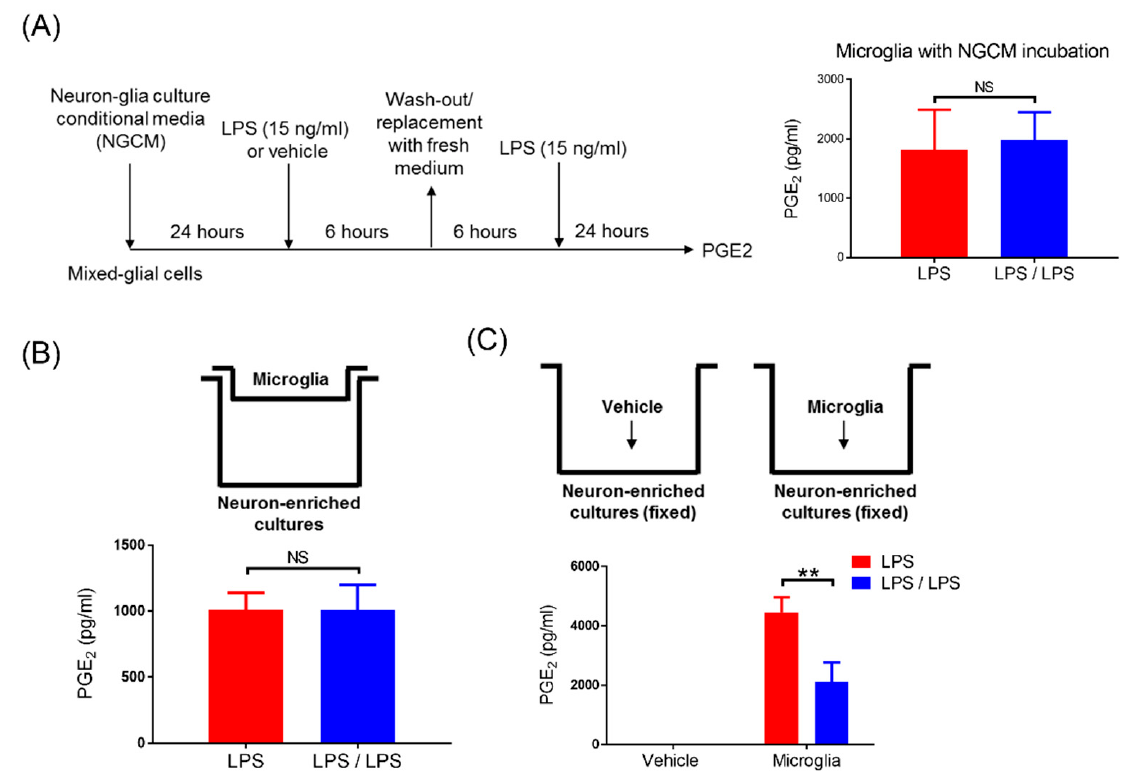
Figure 3. Neural contacts reversed the failure of PGE 2 tolerance in microglia. ( A ) After 24 h incubation with neuron–glial condition media (NGCM), mixed glia (MG) cultures were subjected to the LPS-treated and LPS/LPS-treated regimen, as indicated in the right panel. PGE 2 production in the supernatant of these treated MG cells after 24 h of treatment was measured by ELISA. Data are expressed as the mean ± SEM from three independent experiments in duplicate. NS: no significant differences. ( B ) Microglia were added into Transwell inserts while neurons grew confluent in the lower compartment of the 24-well plate, as indicated in the upper panel. After 24 h of incubation, these cells were applied to the LPS-treated and LPS/LPS-treated regimen. A supernatant level of PGE 2 in these treated cells was detected by ELISA at 24 h of treatment. Data are expressed as the mean ± SEM from three independent experiments in duplicate. NS: no significant differences. ( C ) As indicated in the upper panels, the fixed neuron-enriched cultures were prepared and added with or without microglia. After 24 h of incubation, microglia were applied to the LPS-treated and LPS/LPS- treated regimen. A supernatant level of PGE 2 in these treated microglia was measured by ELISA 24 h after treatment. Three independent experiments were performed in duplicate. Data are expressed as the mean ± SEM, LPS group versus the LPS/LPS group. ** p < 0.01. NS: not significant -. Previous studies demonstrate that the activation of toll-like receptor 4 (TLR4) by LPS is critical for downstream inflammatory [29,30], anti-inflammatory [10], and tolerance responses [31]. Thus, we determined whether the TLR4-derived signal participated in the modulation of microglial PGE 2 tolerance by neurons. Due to LPS-contained hydrophobic multi-acyl chains forming aggregates or micelles in aqueous solutions, the accessory LPS- binding proteins (LBPs) are required to mediate the sensitive recognition of LPS as well as their efficient transfer to the TLR4 [32,33]. After binding to LPS, the TLR4 signaling cascades are activated in the host immune response [30]. Therefore, by using serum-free medium (no LBP) with or without addition of recombinant LBP protein to incubate NG cells, the role of TLR4 signal in PGE tolerance was studied (Figure 4A, left panel). Our data revealed that during the ET treatment, PGE 2 reduction occurred in NG cells at 24 h in the presence of serum medium-contained LBP (100 ± 3.11 vs. 23.79 ± 1.35, p < 0.01, two-way ANOVA, Figure 4A, right panel). Conversely, in serum-free media (no LBP), PGE 2